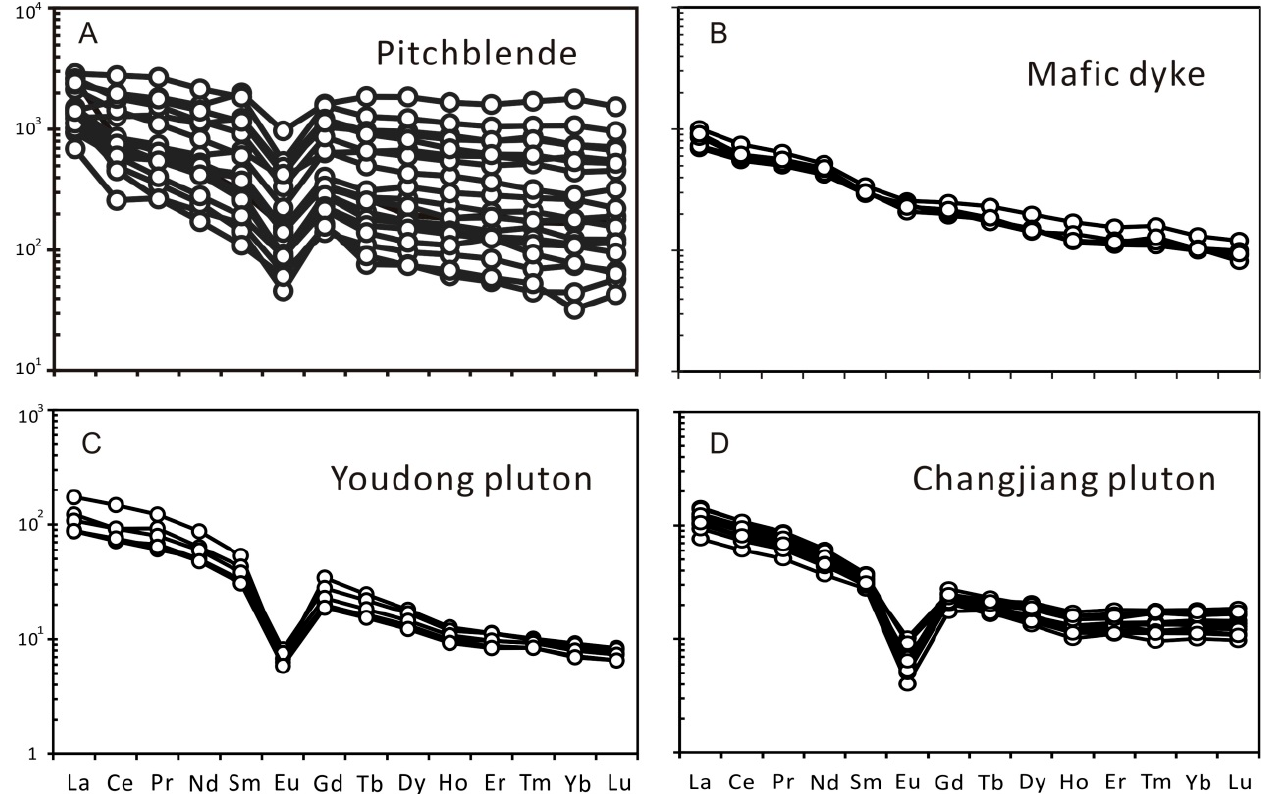
Figure 7. Chondrite-normalized REE patterns of ( A ) pitchblende from the Mianhuakeng deposit, ( B ) mafic dykes, ( C ) Indosinian Youdong granite, and ( D ) Yanshanian Changjiang granite. The REE data of mafic dykes, Youdong and Changjiang granite are from Zhan [32], Huang et al. [27] and Zhang et al. [29], respectively.